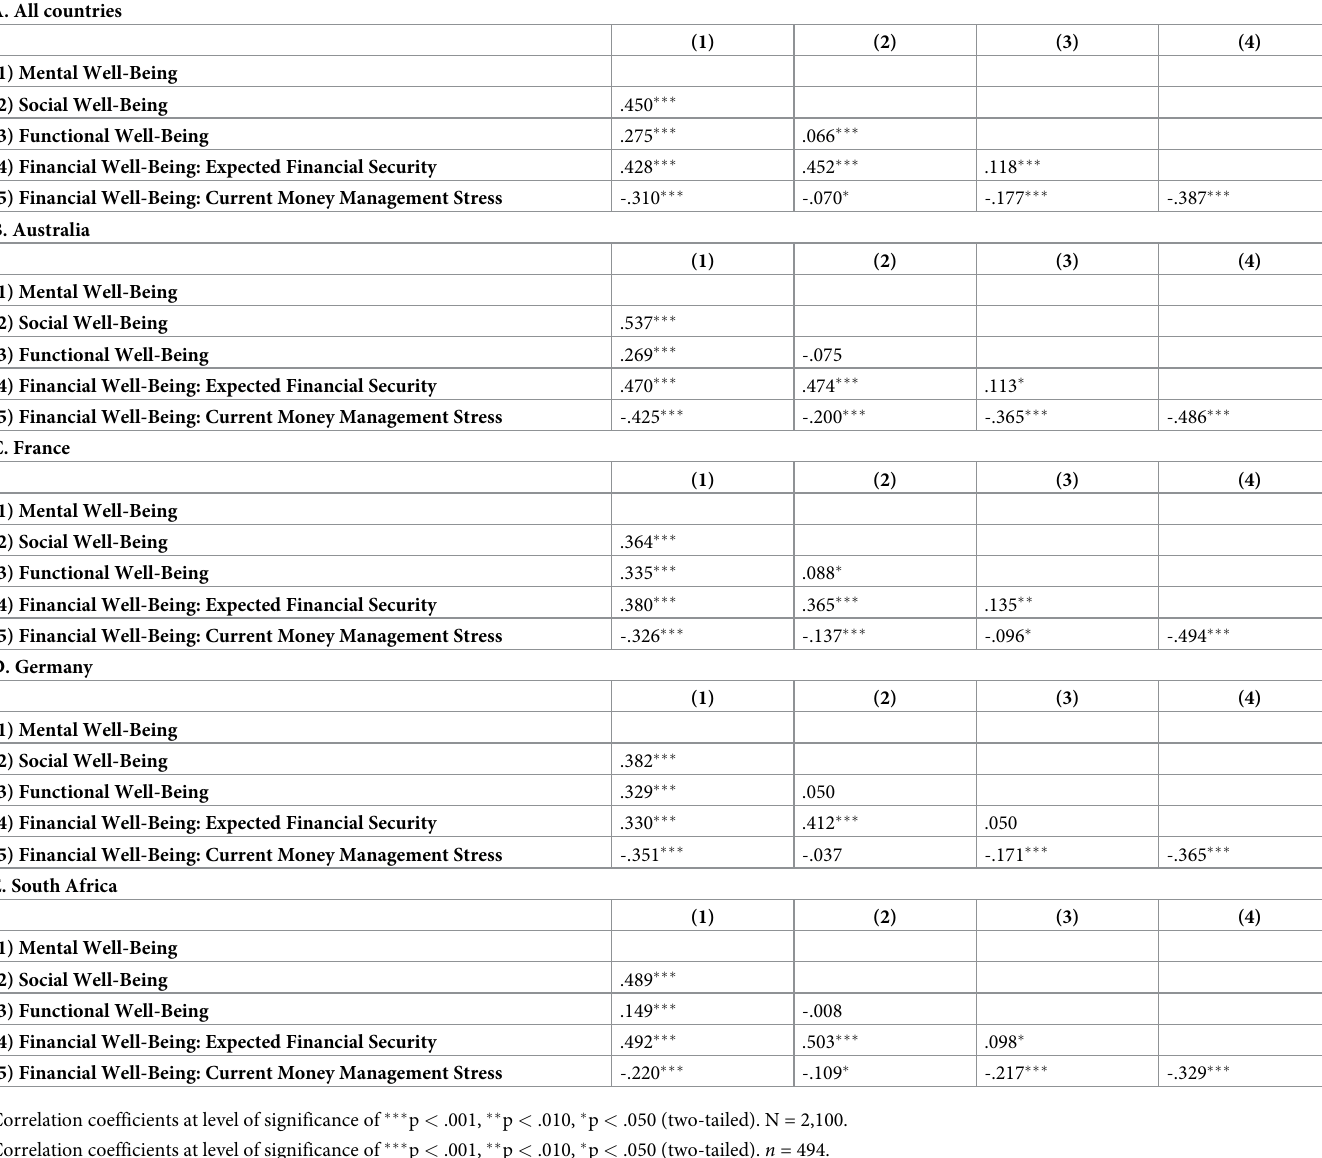
Table 6. Correlations between the different dimensions of survey respondents’ well-being during the COVID-19 pandemic. A. All